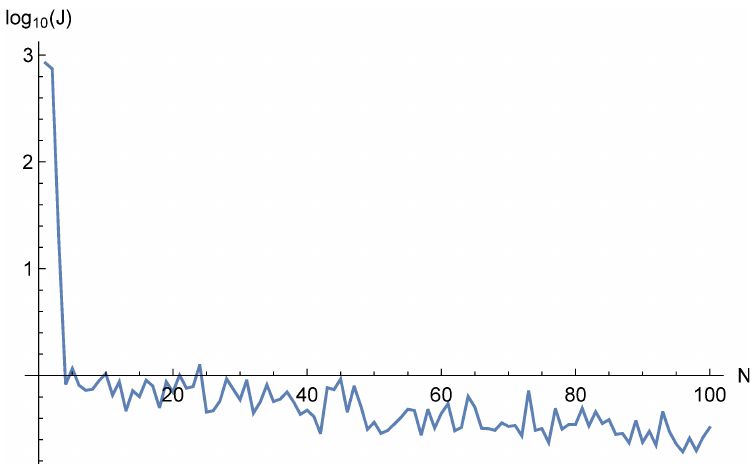
Figure 3. Plot of training loss J history of neural network solution nn 5 ( x ) (9) to problem (30), parameter value s = 0.1, with respect to number N of training epochs. The number of hidden layer neurons n = 5; Gaussian activation